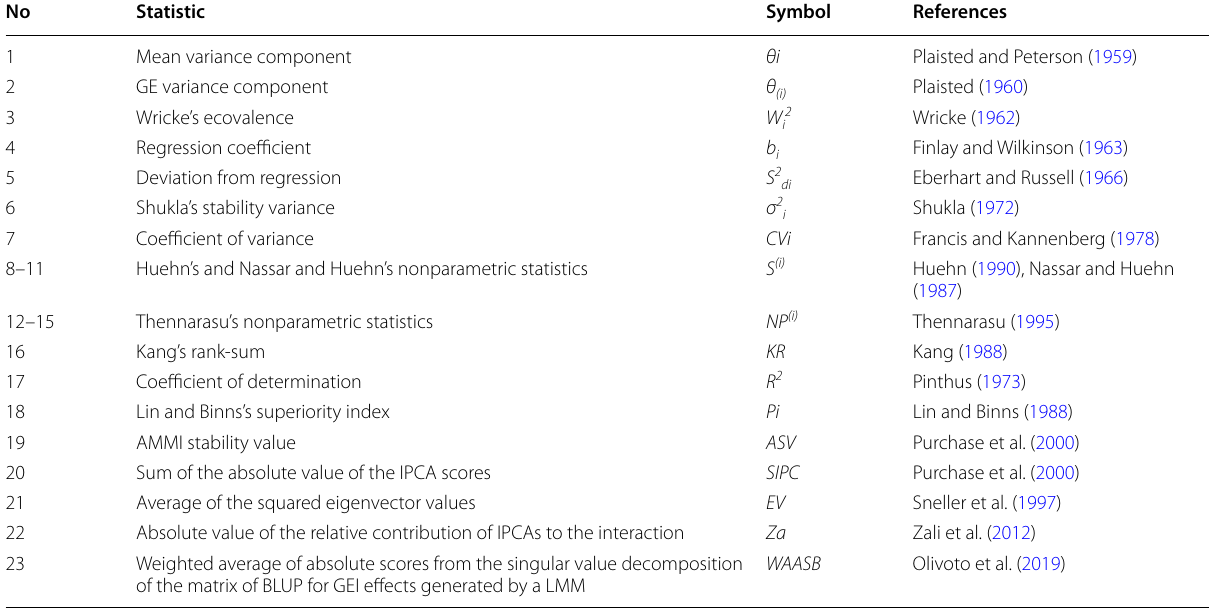
Table 1 List of calculated stability statistics in this study